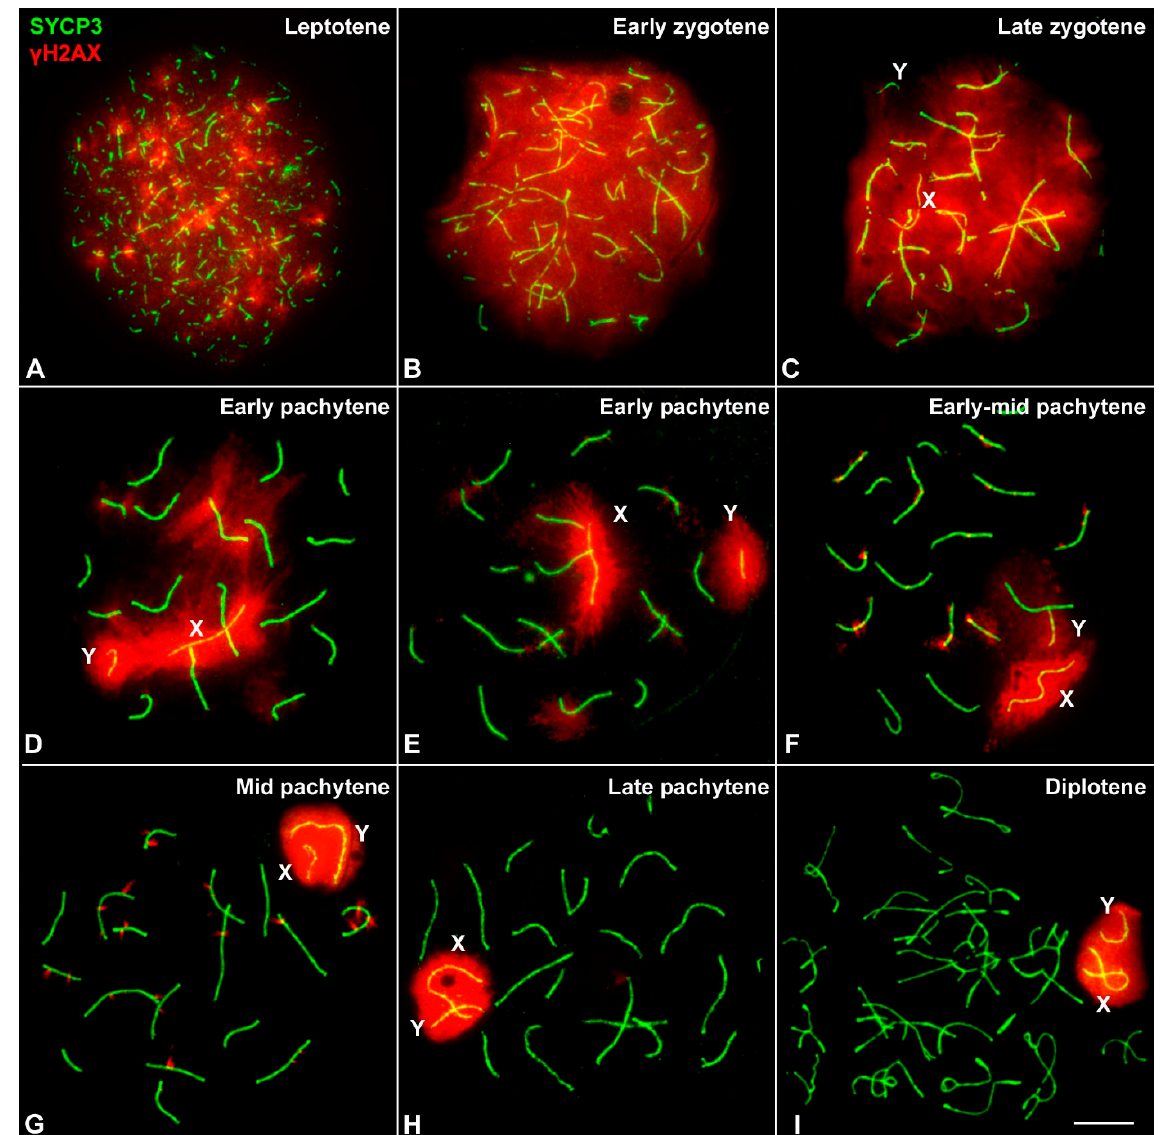
Figure 2. Prophase I progression in M. mattheyi spermatocytes. SYCP3 (green) and γ H2AX (red). ( A ) Leptotene. Axial elements (AEs) appear as short filaments and γ H2AX labelling appears as large foci scattered over the nucleus. ( B )